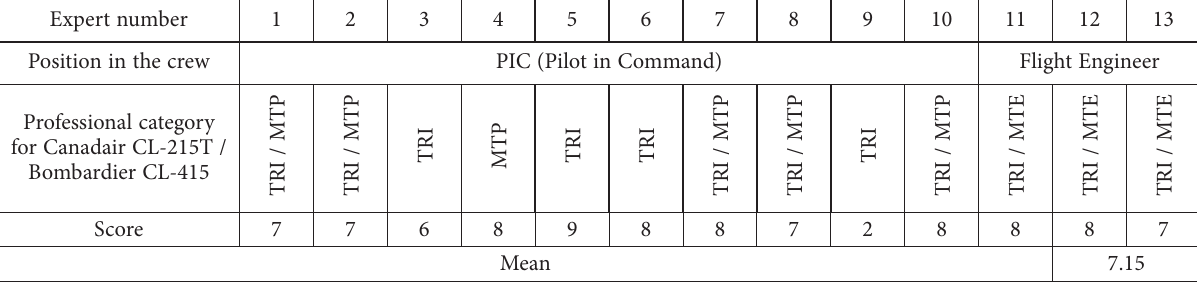
Table 5. Scores assigned to the second task by the group of experts from Sample 2 Expert